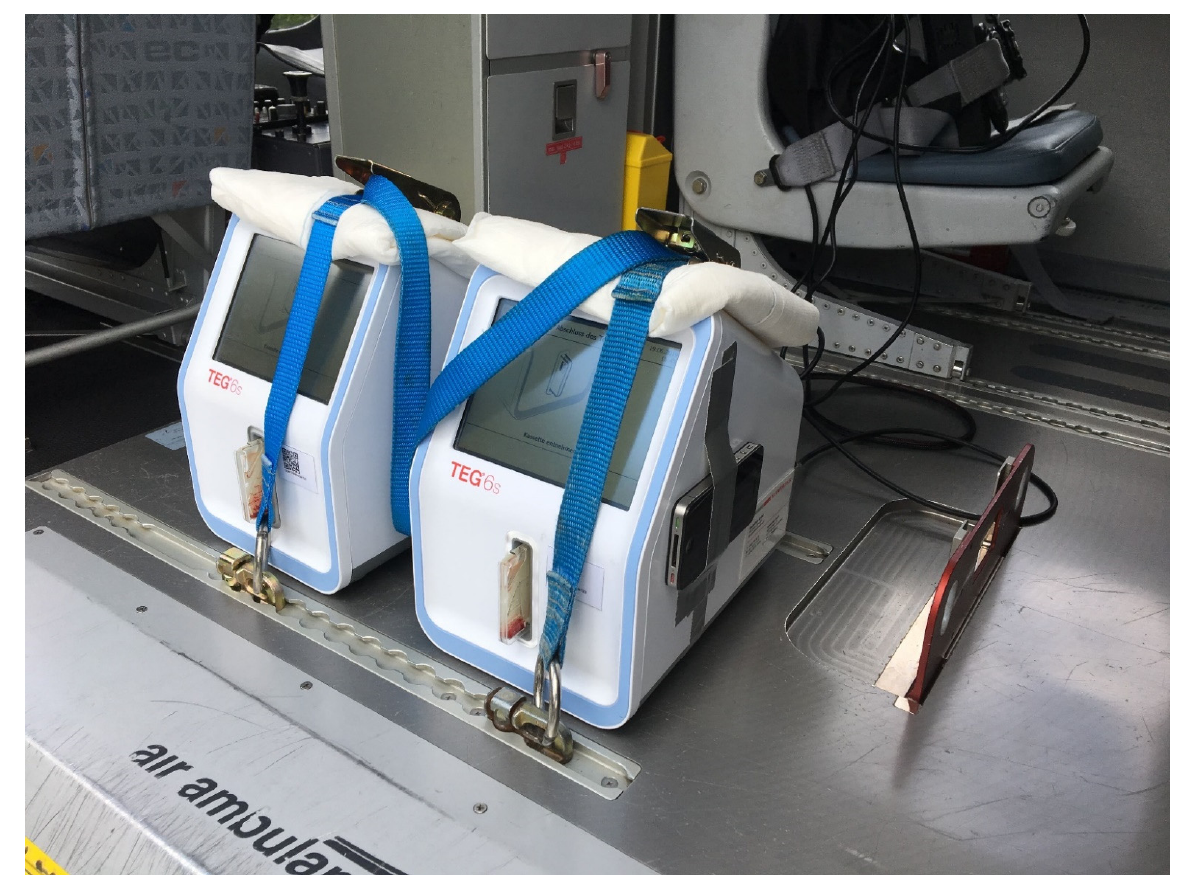
Figure 1. TEG6s devices mounted on the helicopter floor. In contrast to the picture, the device for vibratometric measurement was fixed to the floor for study measurements.